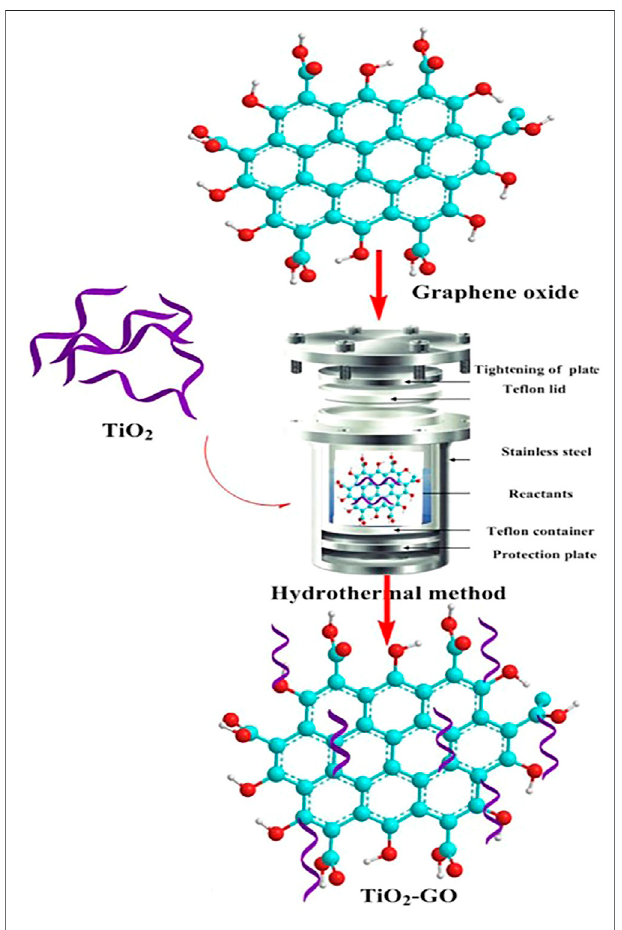
FIGURE 7 | Hydrothermal for the preparation of TiO 2 -modi fi ed graphite (Nehra et al., 2019).